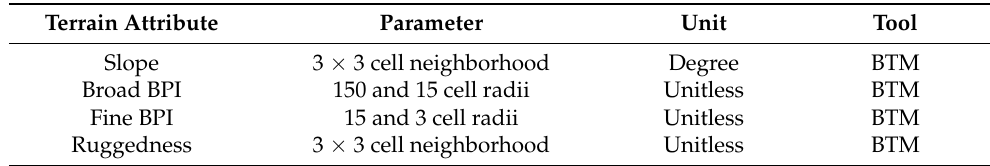
Table 1. Terrain attributes generated from GEBCO_2021 bathymetry using the BTM tool in the marine general geomorphometry